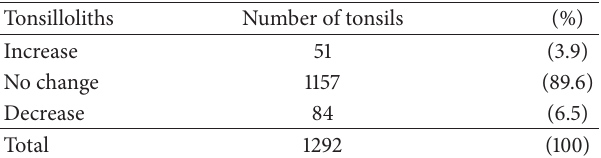
Table 3: Change with time in the number of tonsilloliths per pala- tine